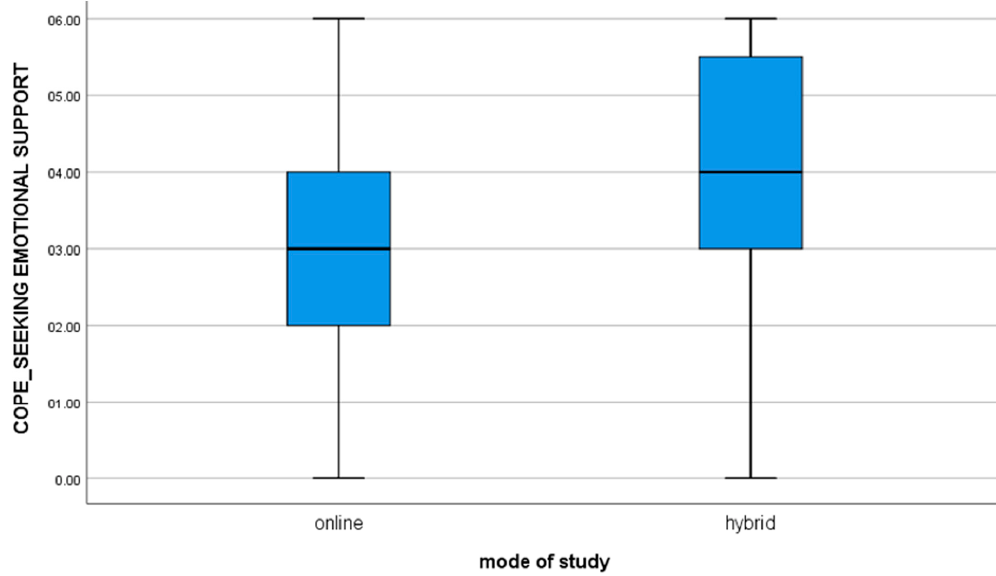
Figure 4. For the variable COPE_SEEKING EMOTIONAL SUPPORT.